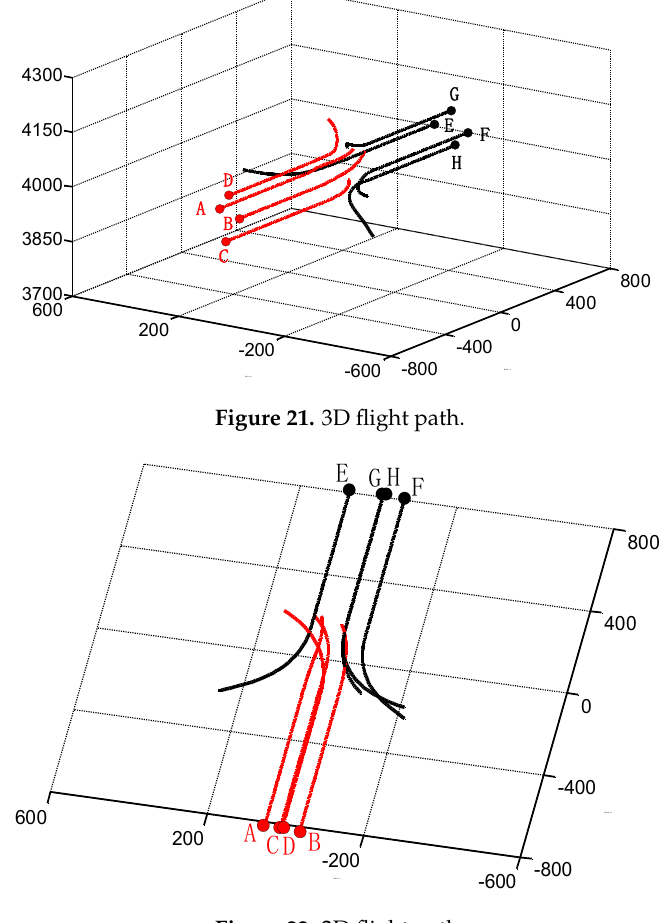
Figure 22. 2D flight path.